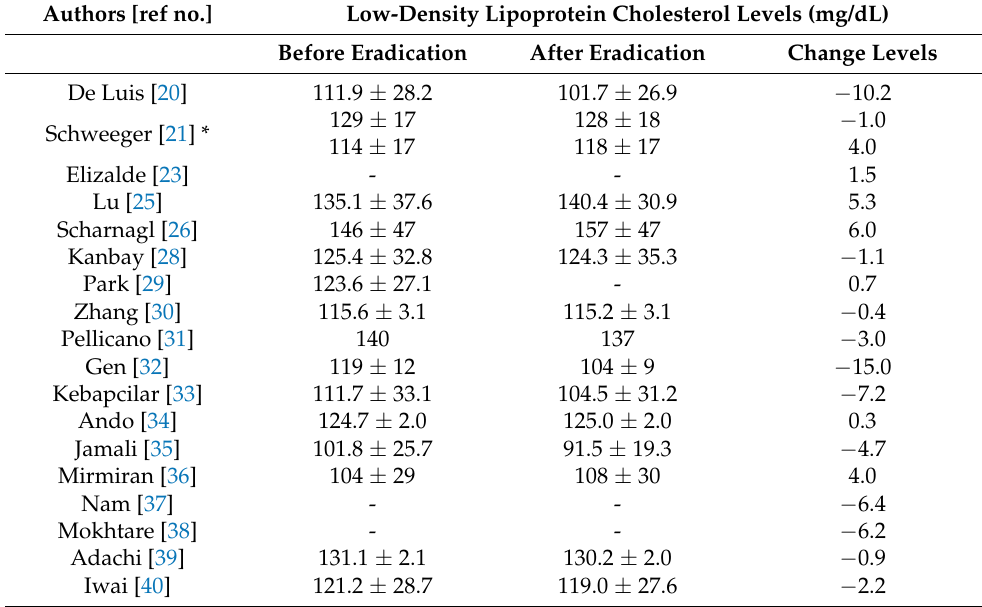
Table A3. Summary of levels of low-density lipoprotein cholesterol before and after eradication. Authors [ref